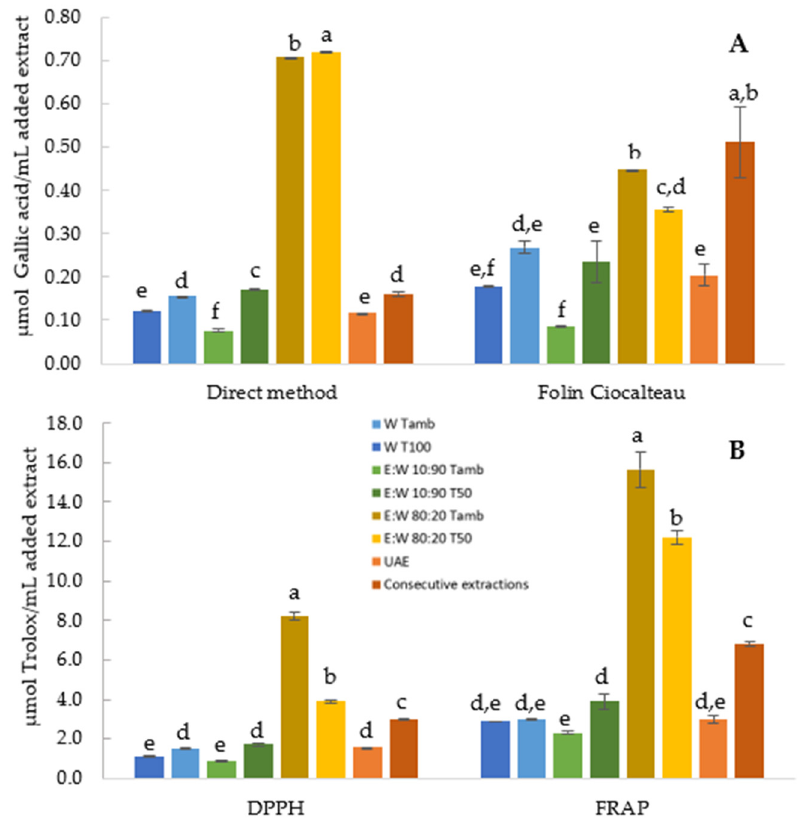
Figure 2. Total phenolic content ( A ) and antioxidant activity ( B ) of different pineapple peel extracts produced by the diverse methods studied. Abbreviations: W—water as solvent; E:W—ethanol:water mixture as solvent; Tamb, T100 and T50—extraction at ambient temperature, 100 and 50 °C, respectively; UAE—ultrasounds assisted extraction. Means with different letters indicate significant differences in extracts ( p < 0.05).